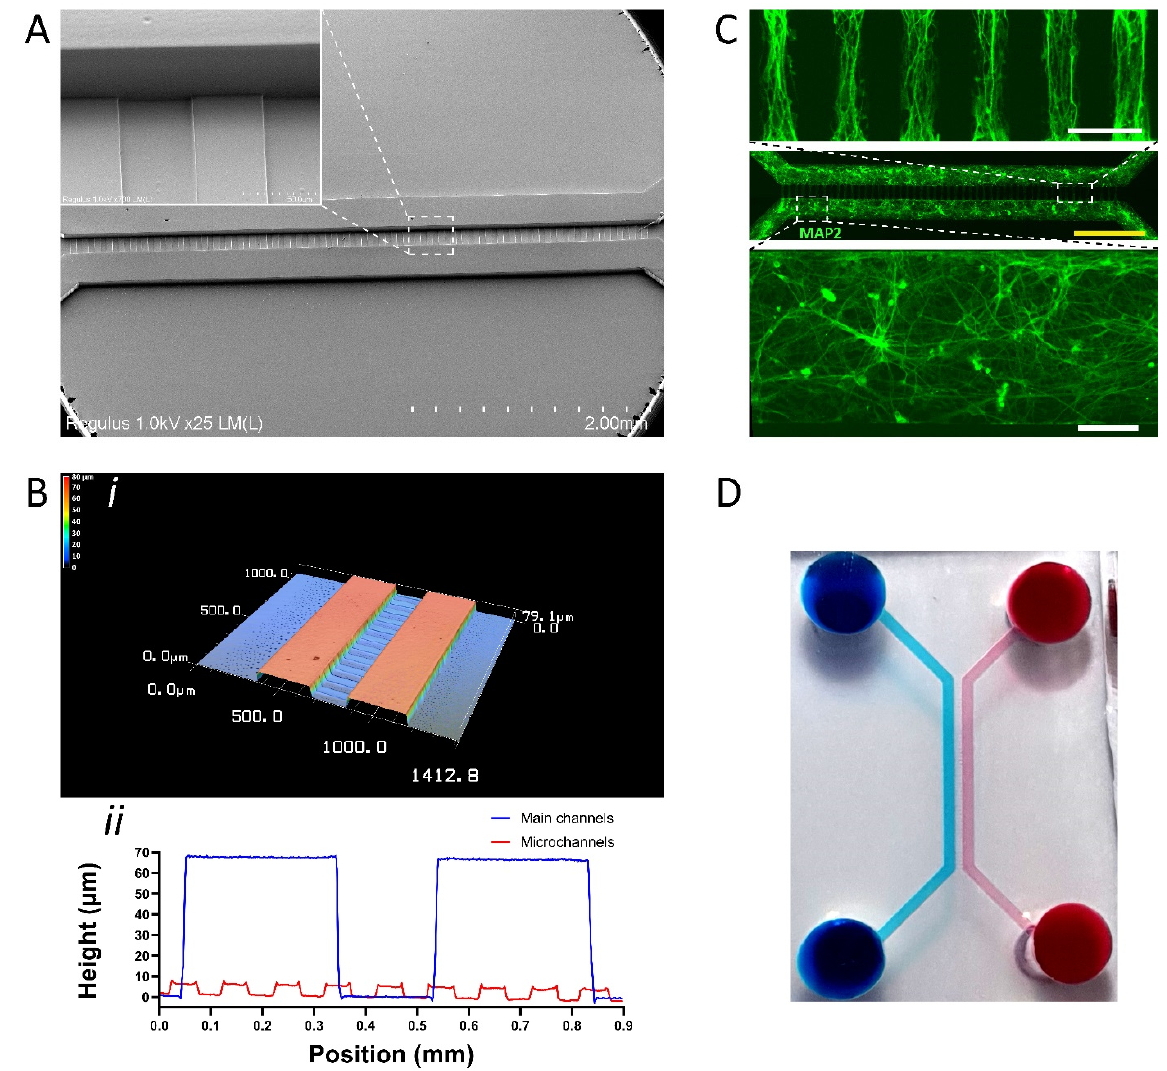
Figure 4. Multi-level SU-8 microstructures to fabricate microfluidic chips with channels of different heights. ( A ) SEM image showing microstructures of a different height. The insert shows an enlarged area of the main channel and perpendicular microchannels of a different height. ( B ) Optical profilometric 3D scan of middle portion of multi-level microfluidic chip. (i) Overview of a 3D scan. (ii) Height measurements of the main and microchannels. ( C ) Representative immunofluorescence image of MAP2-positive hiPSC-derived neurons upon 7 days of culture in a multi-level microfluidic chip. Top dashed box shows an enlarged area of neurite protrusions in microchannels. Bottom dashed box shows an enlarged area of hiPSC-derived neurons cultured in the main channel. ( D ) Photograph of fabricated chip showing fluidic isolation as evident by the blue and red food dyes. White scale bars: 100 µm. Yellow scale bar: 1000 µm.